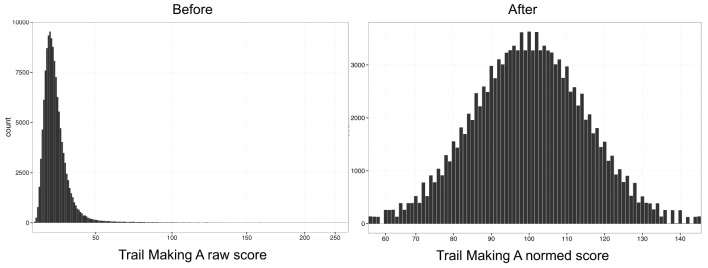
NCPT normalization. Score distributions for Trail Making A before (left) and after (right) the normalization procedure. Each NCPT subtest is scaled following a percentile rank-based inverse normal transformation. The position of that percentile on a normal distribution is used to convert the raw score to a scaled score where the distribution has a mean of 100 and a standard deviation of 15.